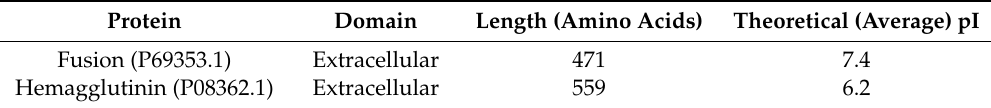
Table 1. MV has two surface proteins: hemagglutinin and the fusion protein. The theoretical pI was calculated for the extracellular domains of these two proteins based on the amino acid sequences [26]. Protein Domain Length (Amino Acids) Theoretical (Average) pI Fusion (P69353.1) Extracellular 471 7.4 Hemagglutinin (P08362.1) Extracellular 559 6.2